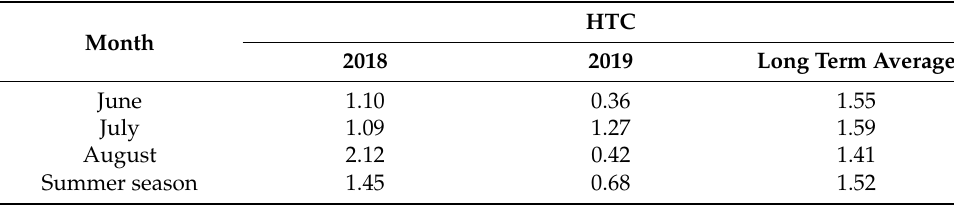
Table 5. Hydrothermal regime in Traku Voke area during summer